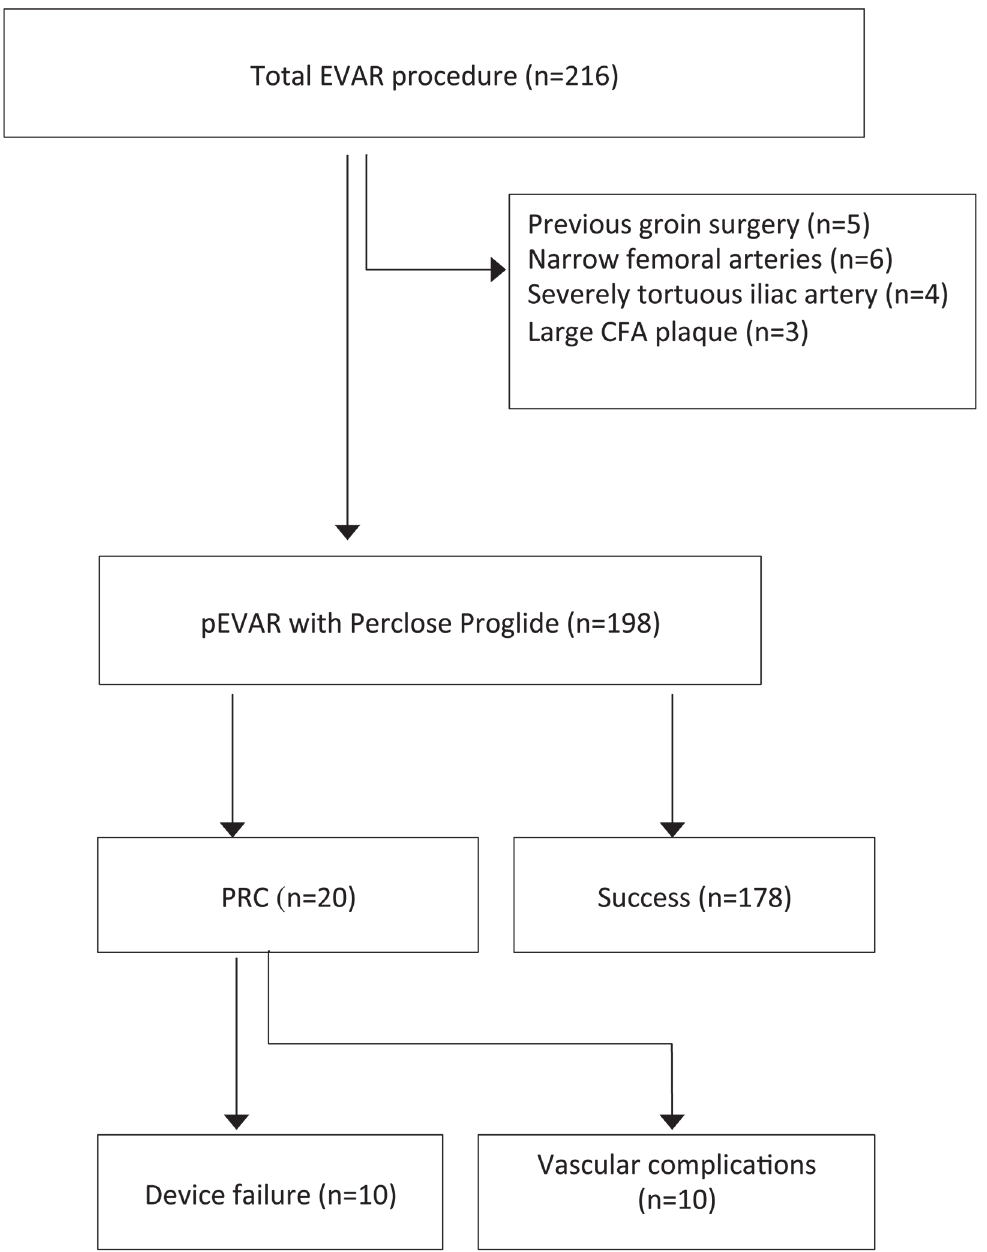
Fig 1. The Flowchart of this study. The flowchart depicts the inclusion and the exclusion of the study population in this study and the occurrence of Perclose Proglide-related